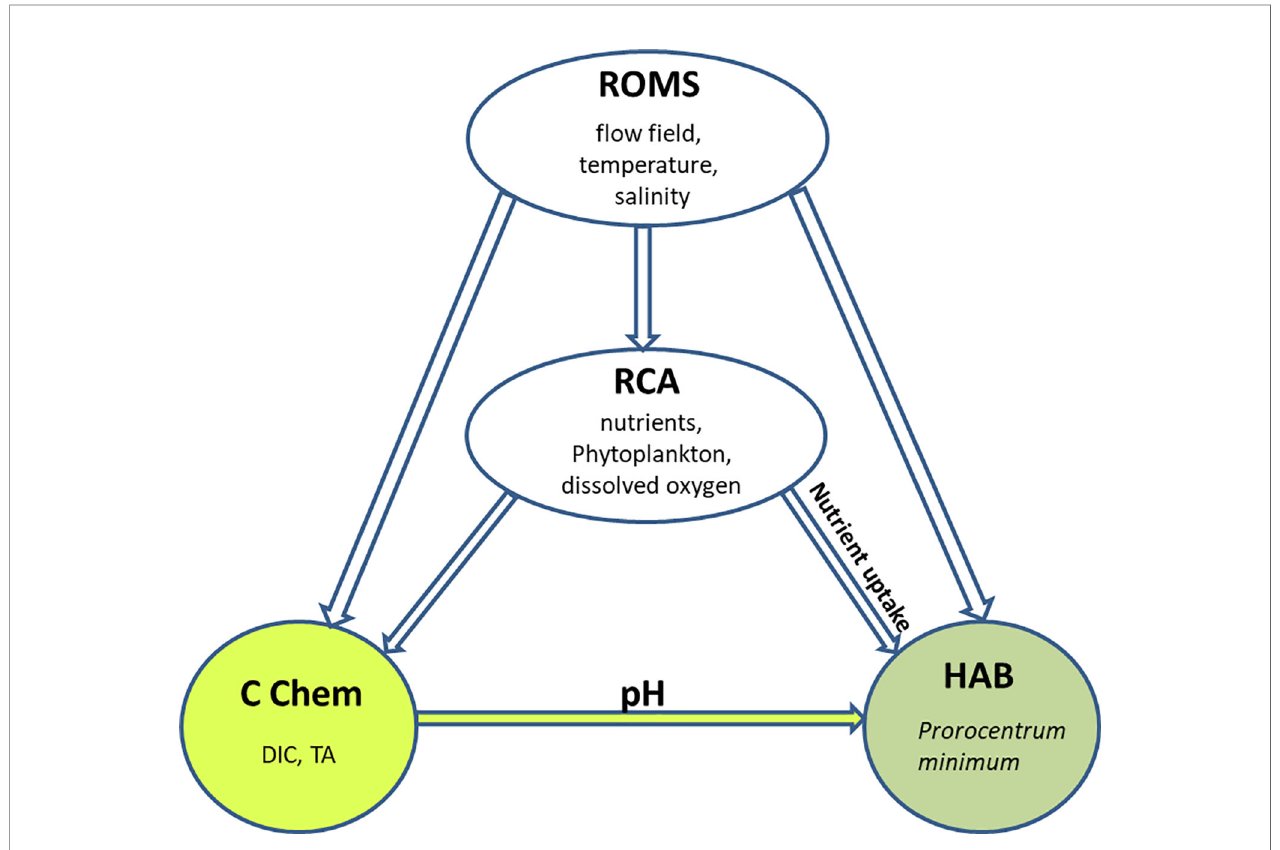
FIGURE 1 | A conceptual diagram of the ROMS-RCA-CC- Prorocentrum coupled model: ROMS is the hydrodynamic model, RCA is the biogeochemical model, CC is the carbonate chemistry model, and HAB is the model for P. minimum